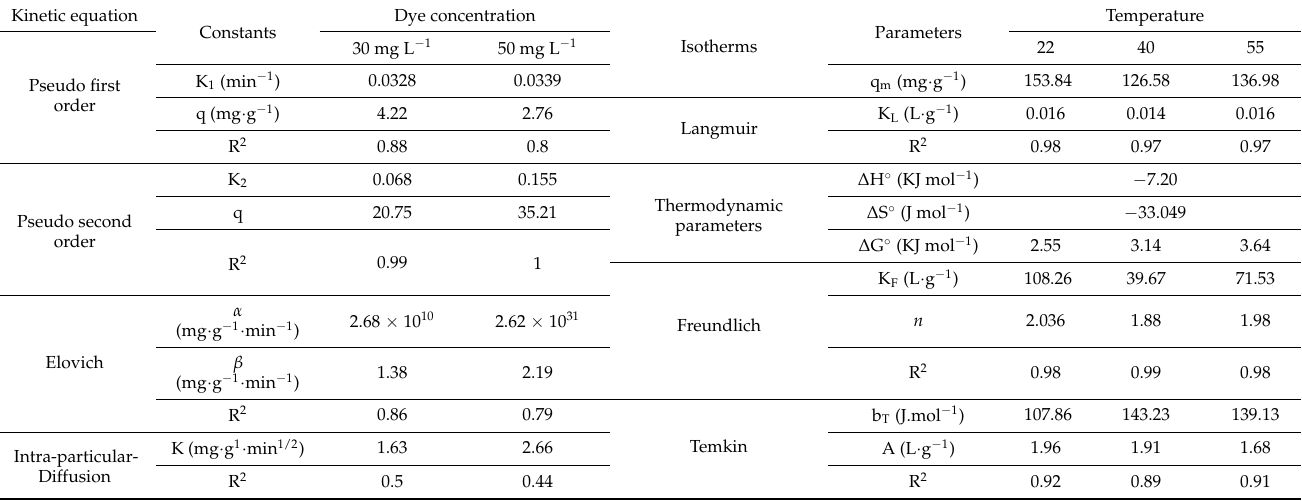
Figure 9. Linearized kinetic data for Crystal violet adsorption: ( a ) First pseudo order, ( b ) Pseudo second order, ( c , d ) Intra-particular diffusion. Table 1. Summarized kinetic data, Langmuir, Freundlich, and Temkin parameters for the adsorption of methylene blue on the surface of extracted cellulose from populus tremula.